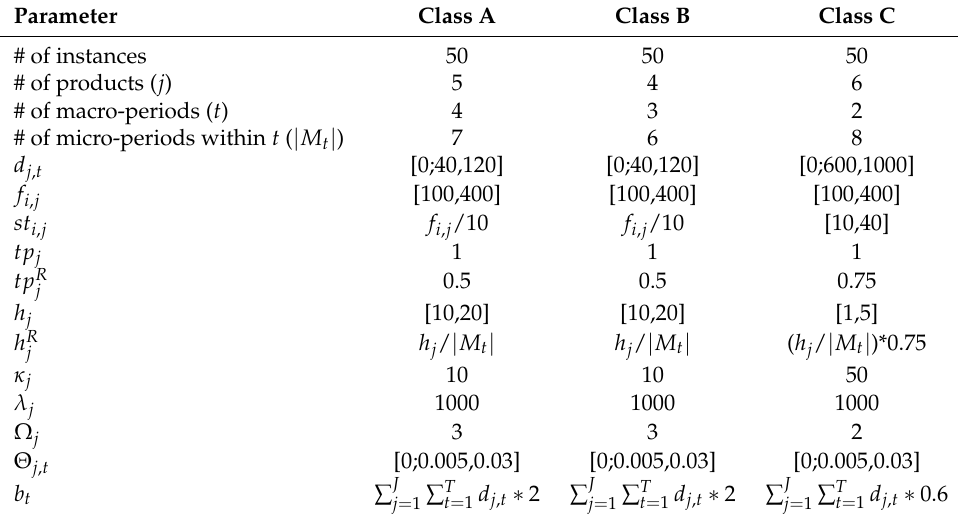
Table 9. Parameter settings for the data